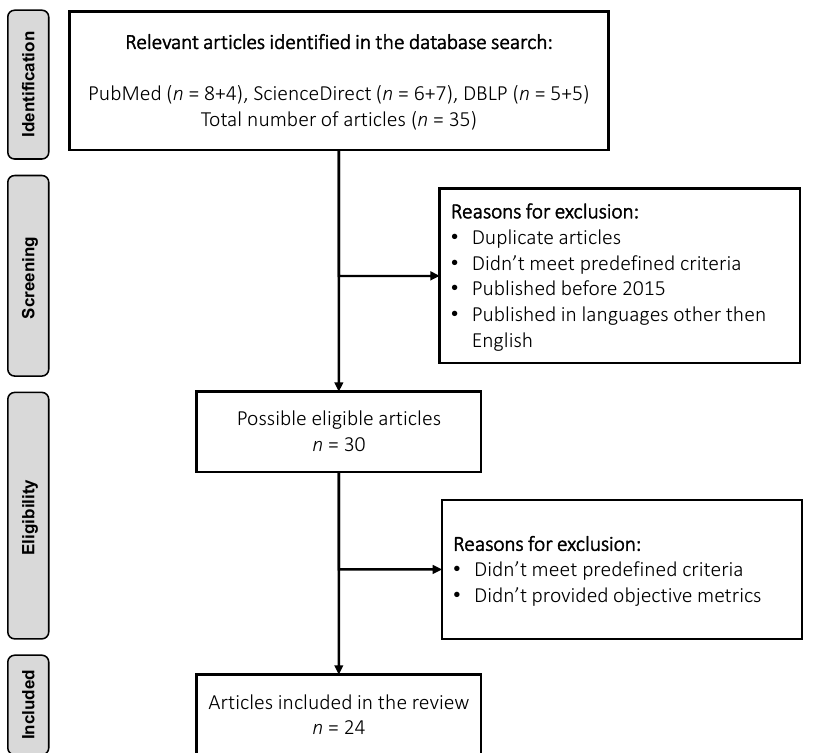
Figure 2. Flow chart of the different phases of the review.